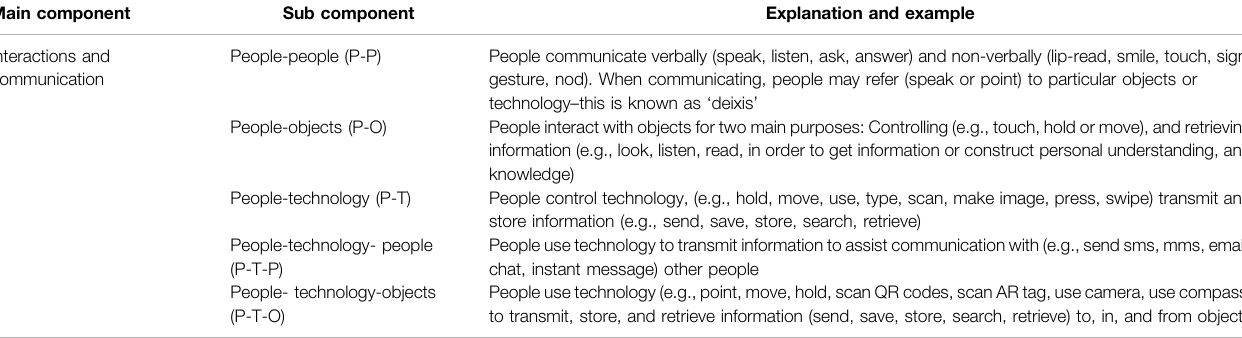
TABLE 3 | Interactions and communication in the technology enhanced interaction framework.